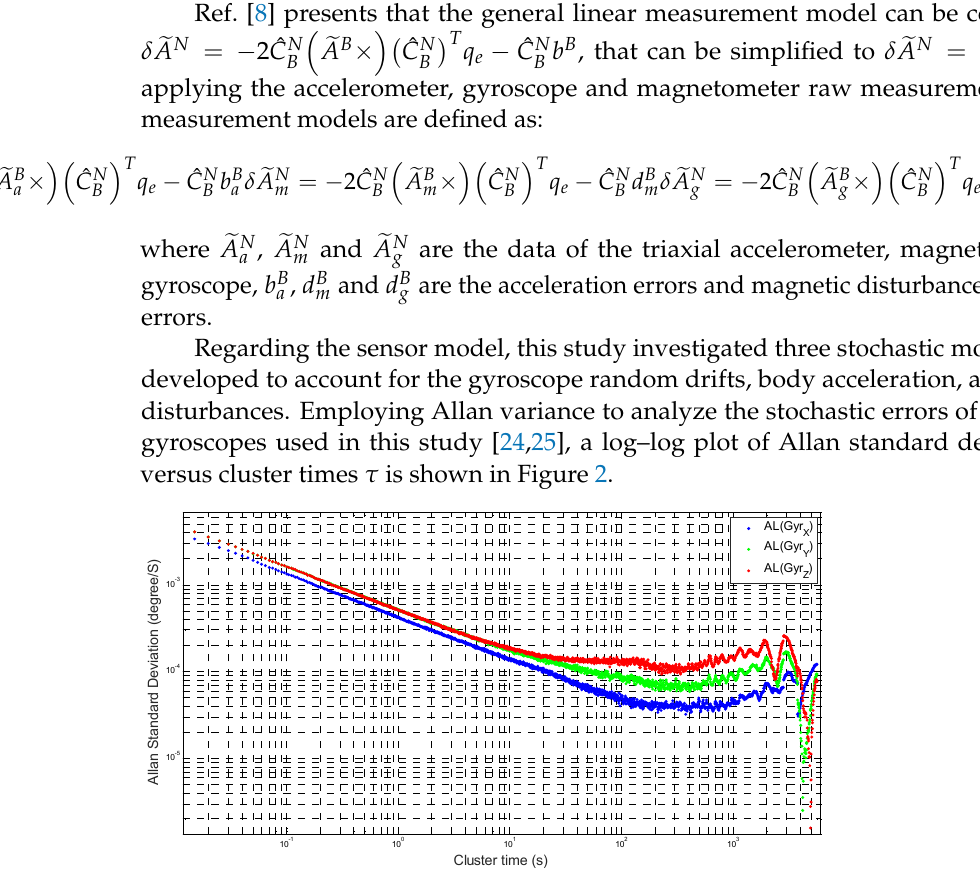
Figure 2. Plot of Allan standard deviation σ ( τ ) versus cluster times τ